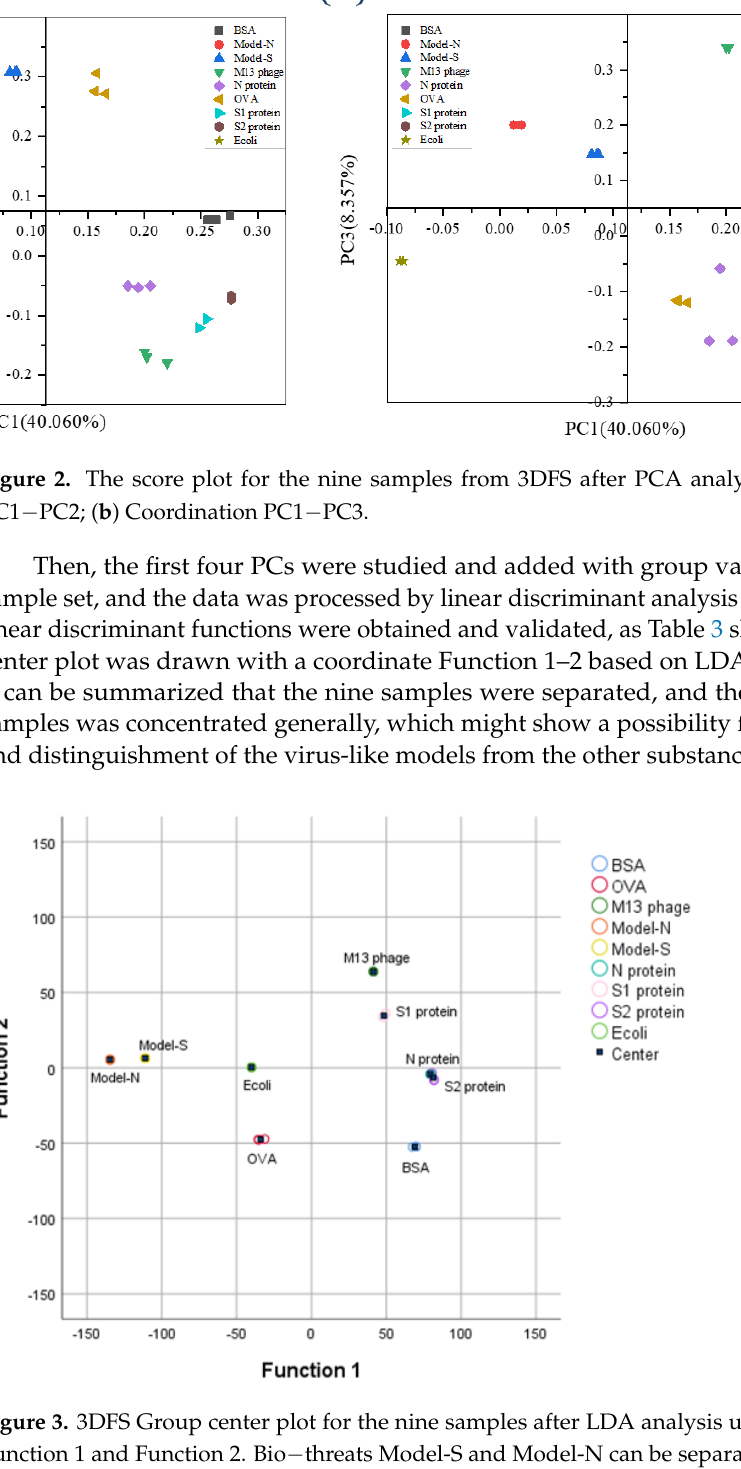
Figure 3. 3DFS Group center plot for the nine samples after LDA analysis under the coordination Function 1 and Function 2. Bio − threats Model-S and Model-N can be separated and distinguished from the other samples.